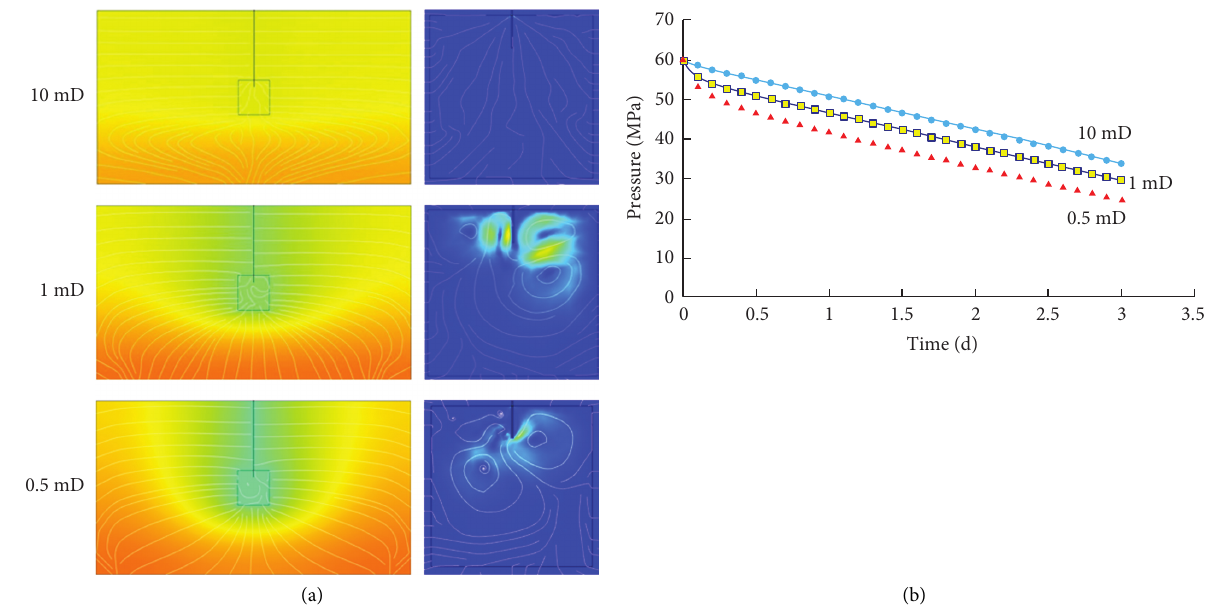
Figure 12: Distribution of pressure and velocity fields with different permeability (a) and pressure comparison of different permeability